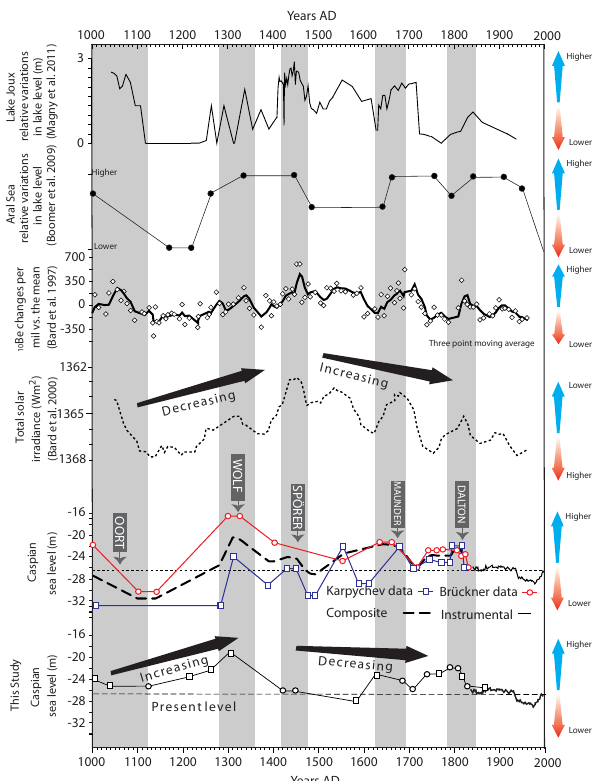
Fig. 10. Caspian sea-level reconstruction for the last millennium based on historical and geological evidence (Table 7). These data are compared with the curves of Br¨uckner (1890) and Karpy- chev (1998, 2001) as well as the Aral Sea level fluctuations (Boomer et al., 2009) in Middle Asia and Lake Joux (Magny et al., 2011) in Europe. The lake-level fluctuations are compared with total solar ir- radiance (Bard et al., 2000) and 10 Be changes (Bard et al., 1997). The increasing and decreasing trends are highlighted on the right side of the graphs. The Aral Sea level fluctuations have not been precisely quantified and are depicted on a relative